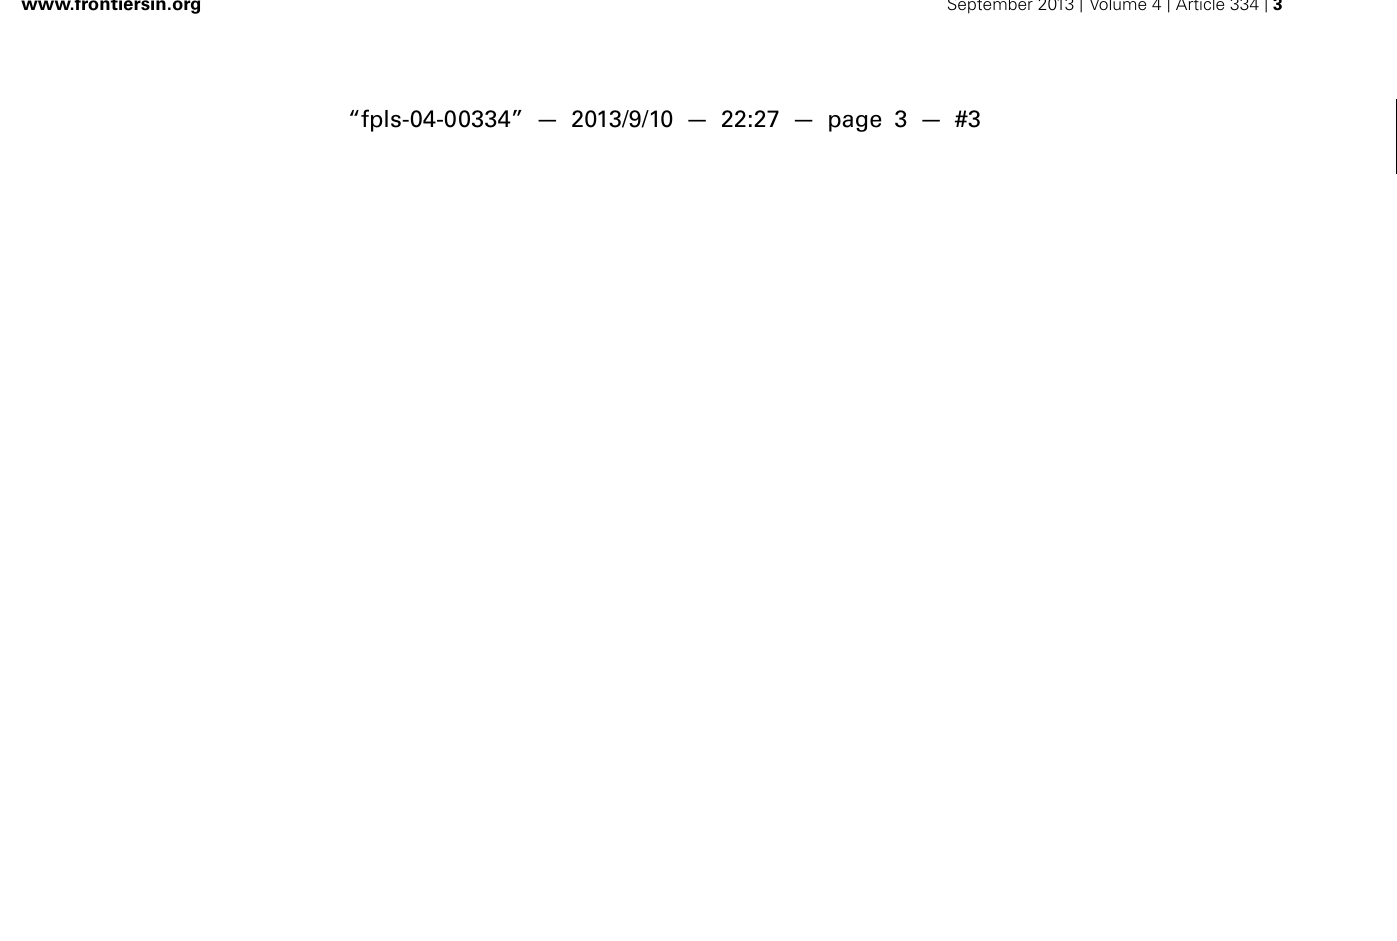
light spectra (indicated by the same color) at the respective position are shown on the right. Open: intensity and spectrum of full sunlight outside the field. PAR: photosynthetic active radiation. FR: far-red